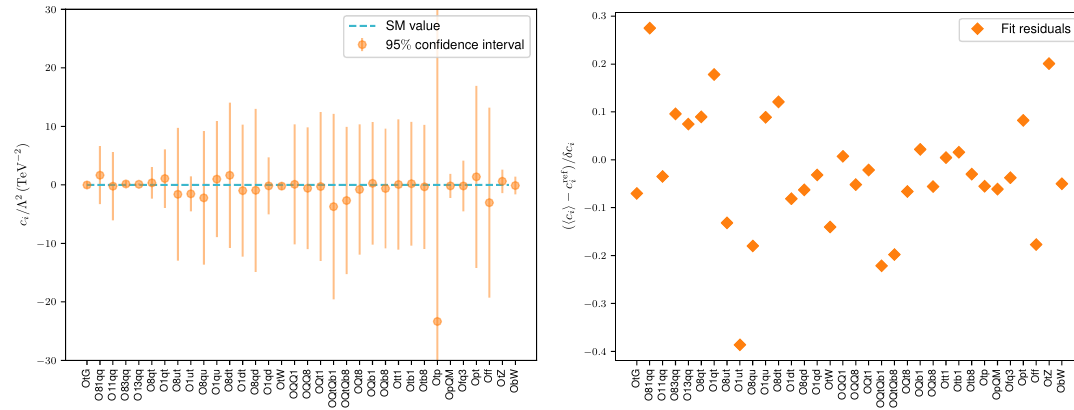
Figure 17 . Left: the best-(cid:12)t values, for the N op = 34 SMEFT degrees of freedom considered in this analysis. The dashed blue line indicates the SM, c i = 0. Right plot: the associated (cid:12)t residuals, which measure the deviation of the (cid:12)t results with respect to the SM value c (ref)